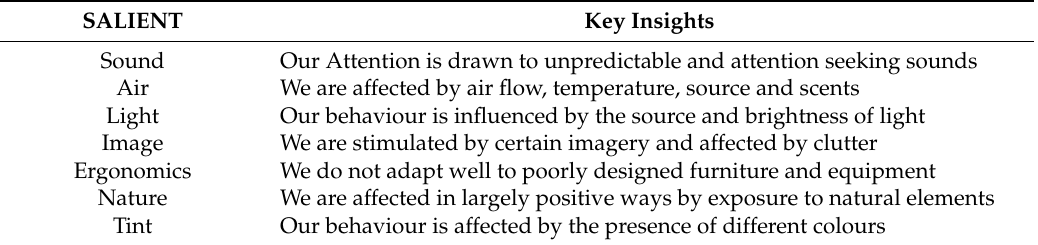
Table 1. SALIENT—key